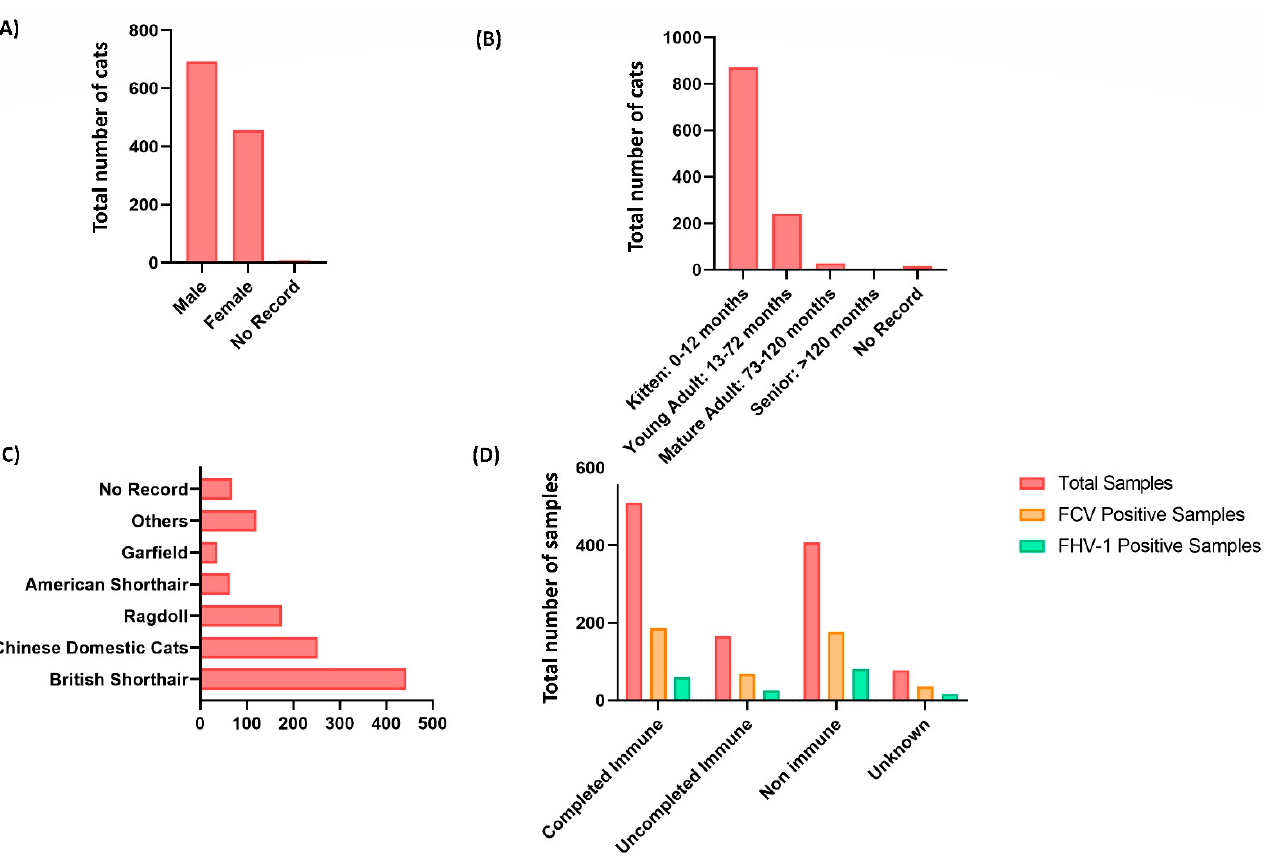
Figure 1. Distribution of upper respiratory tract infection in 1158 collected samples of cats living in Wuhan, China. ( A ) The gender distribution of cats with upper respiratory tract infection; male cats account for a higher proportion than female cats. ( B ) The age range of cats suffering from upper respiratory tract infections. The younger cats suffered the most, notably those aged 0 to 12 months (871 out of 1158). ( C ) The distribution of breeds of cats with upper respiratory tract infections. British shorthair cats account for the highest number of cases (443 out of 1158). ( D ) Immunization status of cats with upper respiratory tract infection, revealing a more significant frequency of infected cats with complete viral immunity.